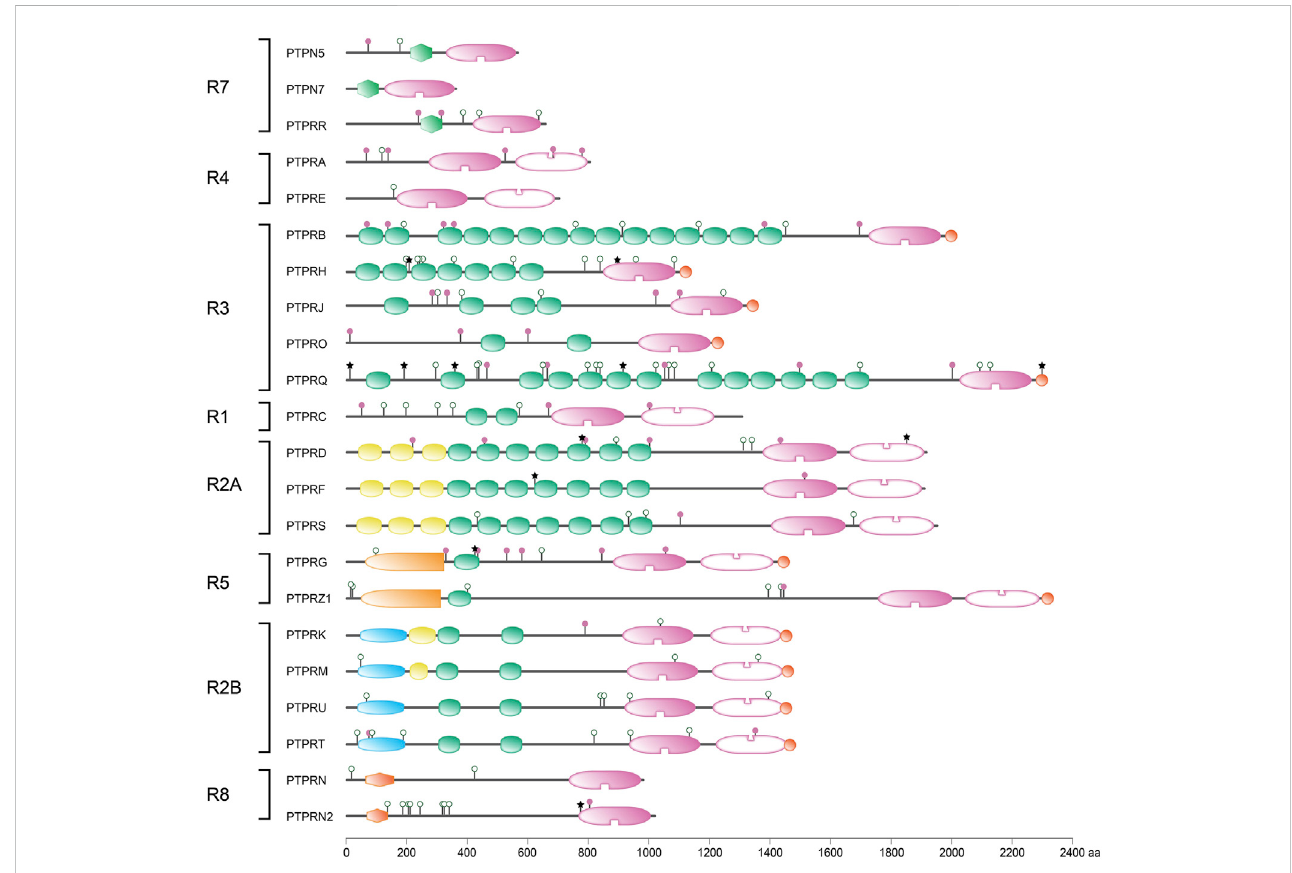
FIGURE 5 Protein sequence variant positions in receptor-type PTPs found in literature or arising from a common SNP. Classi fi cation (left) and protein domain structure build-up (right) of the ‘ R ’ subclass of PTPs are as in Figure 1. PTPN5 and PTPN7 are included here as members of receptor-type subgroup R7. Sequencevariantsarerepresentedbylollipopsonthestructuralcartoons.Thereddishpurplelollipopsrepresentnon-synonymousmutantsthatarediscussed in the text. The black star lollipops re fl ect frame-shift and non-sense variants discussed in the text. Lollipops with green open circles represent nonsynonymous variants occurring in > 1% of the population and have not been linked to phenotypic consequences in the literature. All variant positions and linked corresponding literature references are included in Supplementary Table S1. The horizontal bar at the bottom indicates protein